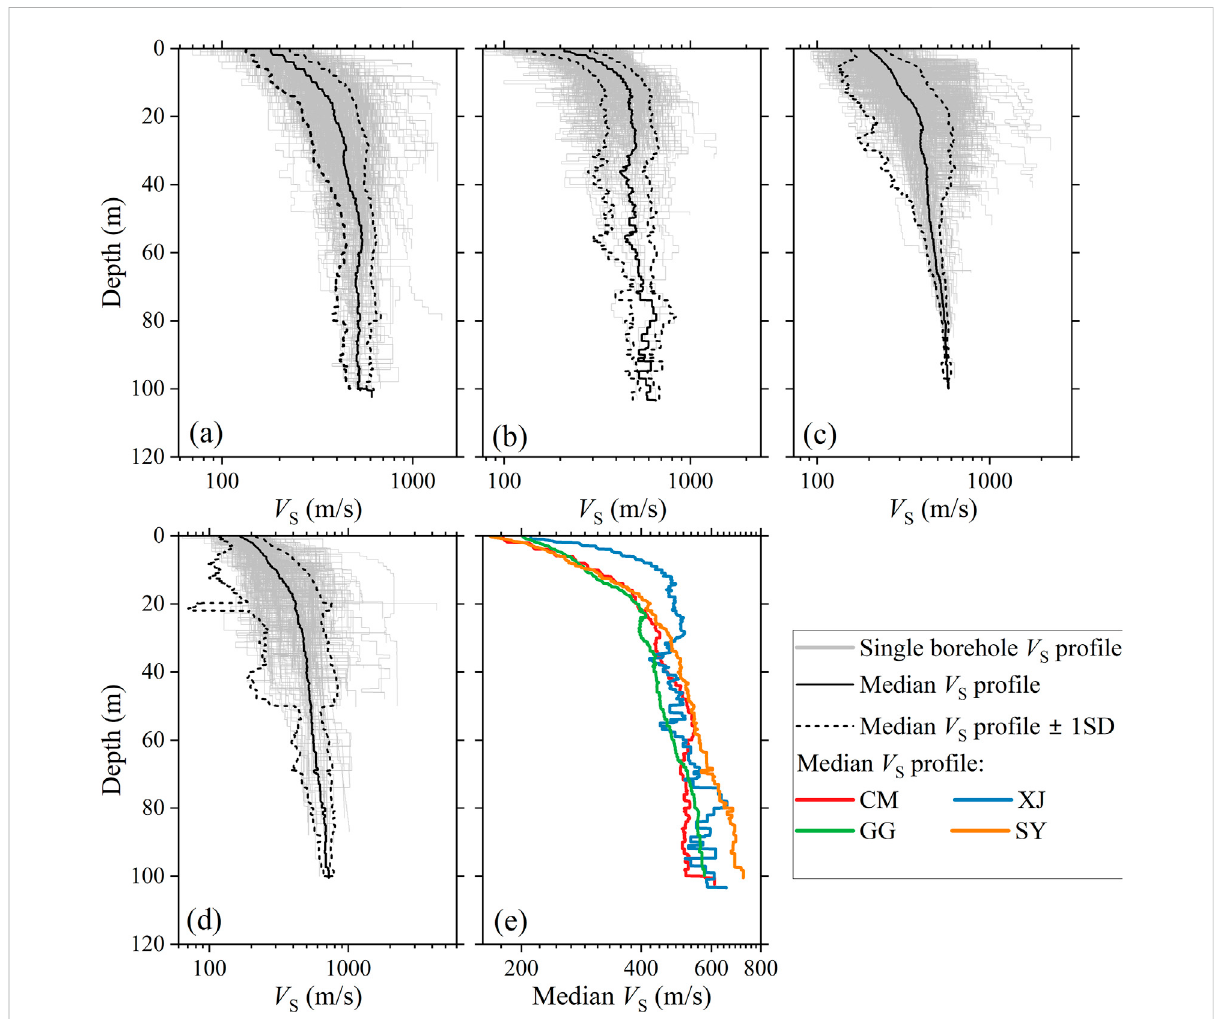
FIGURE 5 The V S pro fi les of Class-II sites in (A) SY, (B) GG, (C) CM, and (D) XJ areas. Solid and dotted lines indicate the median V S pro fi le and the one standard deviation range, respectively, for each region. (E) The median V S pro fi les of the Class-II sites in the four regions are compared in